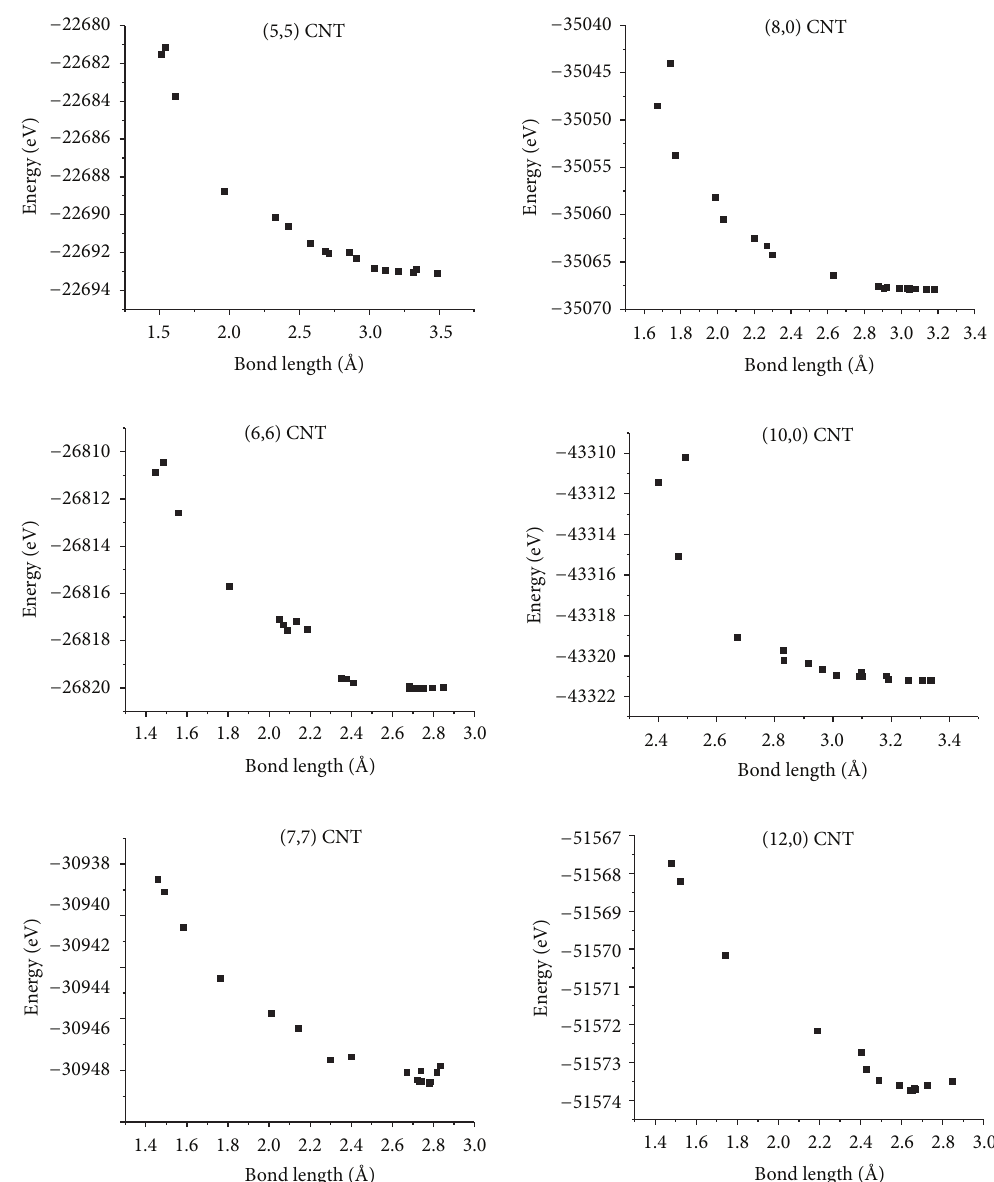
Figure 1: The energy versus the distance between water molecule and the CNT wall during the geometry